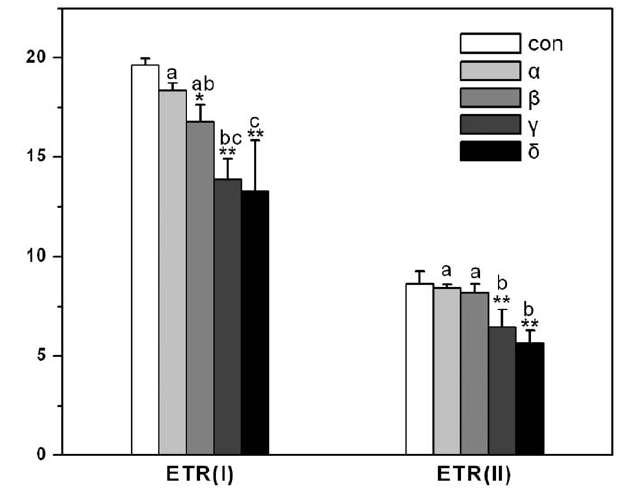
Figure 4. Changes of photosynthetic electron transport rates [ETR (I) and ETR (II)] in Arabidopsis thaliana treated by HCH isomers. Different letters above the columns of HCH isomer treatments show statistically significant differences between them ( p =0.05).